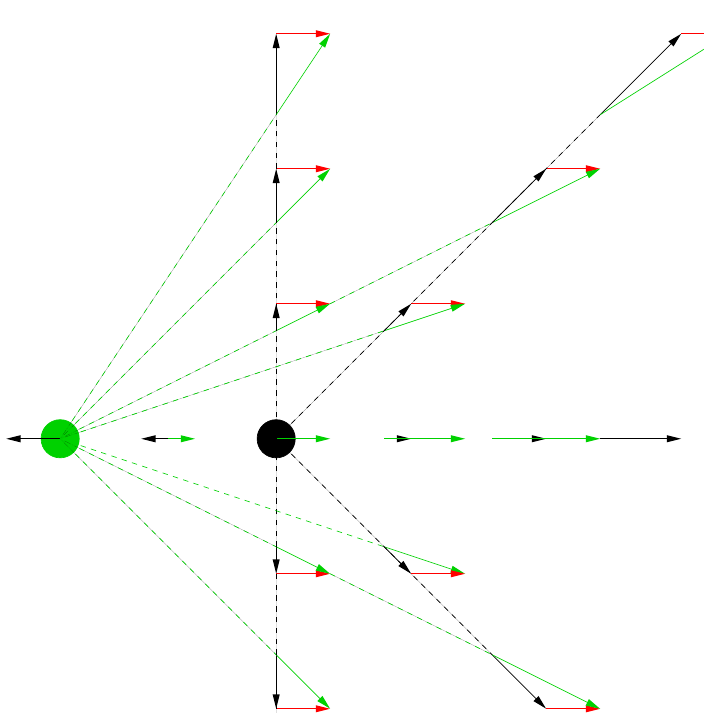
Figure 2: Illustration of the Hubble law. Galaxies at all points of the square grid are receding from the black galaxy at the centre, with velocities proportional to their distance away from it. From the point of view of the second, green, galaxy two grid points to the left, all velocities are modified by vector addition of its velocity relative to the black galaxy (red arrows). When this is done, velocities of galaxies as seen by the second galaxy are indicated by green arrows; they all appear to recede from this galaxy, again with a Hubble-law linear dependence of velocity on